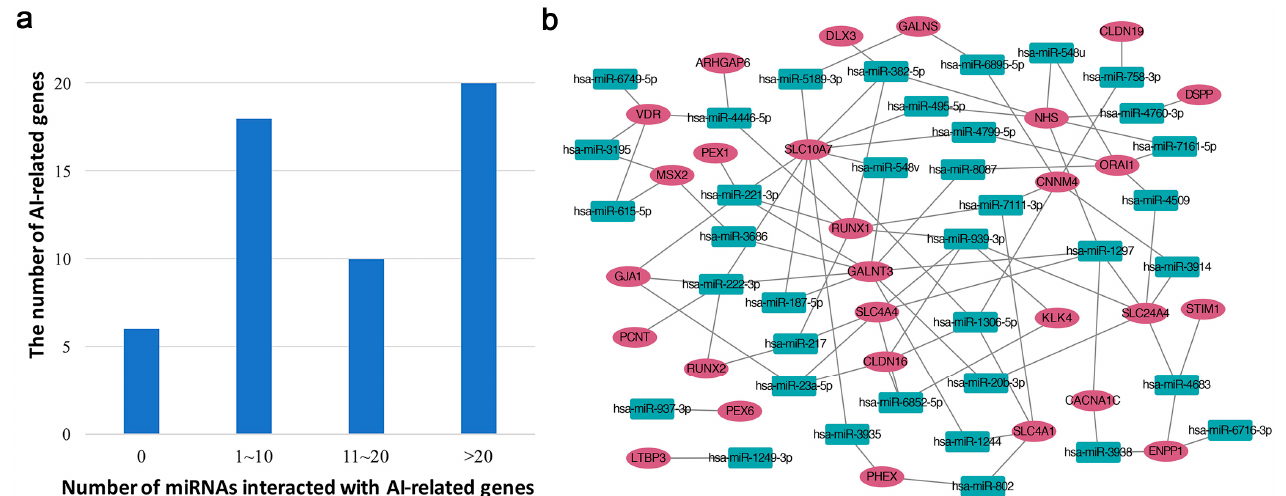
Figure 5. Characteristics of miRNAs associated with amelogenesis imperfecta (AI). ( a ) The distribution of miRNAs interacting with amelogenesis imperfecta-associated genes. ( b ) The enriched miRNA regulation network. Red circles denote genes related with amelogenesis imperfecta. Green squares denote human miRNAs enriched with amelogenesis imperfecta-related genes. An edge is laid when interaction between miRNA and gene has been reported in the database.